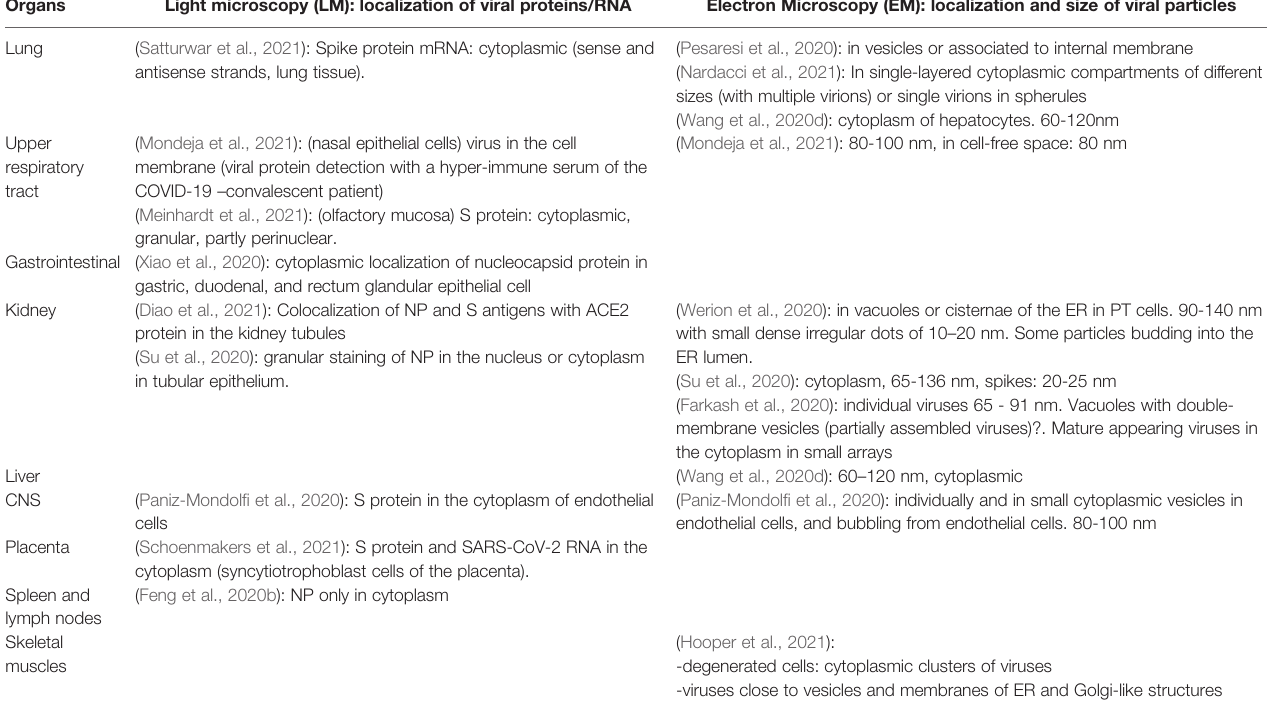
TABLE 1 | Light microscopy used for localization of SARS-CoV-2 proteins/RNA and Electron Microscopy for the detection of virion particles in different organs of SARS-CoV-2 infected individuals. Organs Light microscopy (LM): localization of viral proteins/RNA Electron Microscopy (EM): localization and size of viral